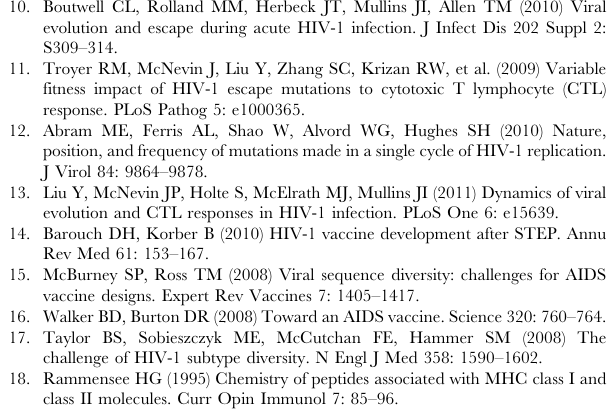
Figure S2 The effect of mutation on overlapping nonamer sequences. A. The numbers represent amino acids of overlapping nonamer sequences. B. A change in one amino acid, for example from C to P at position 9, will affect nine nonamers spanning 17 amino acids (boxed in red).